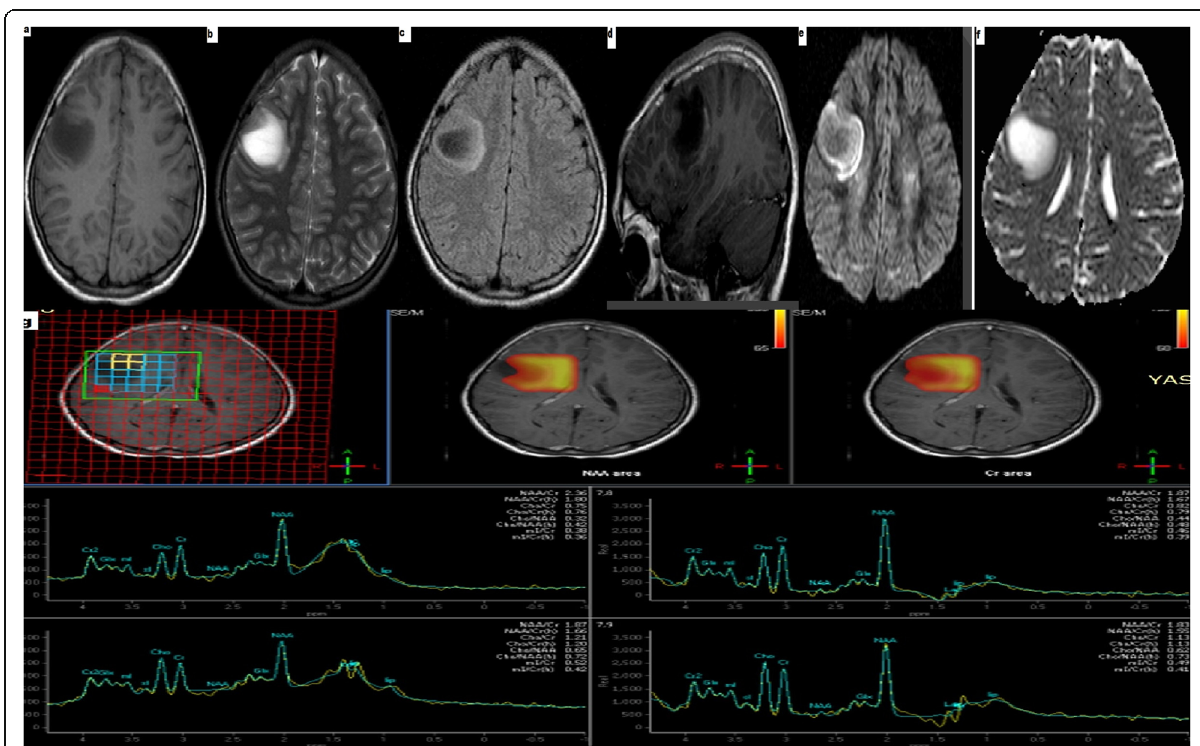
Fig. 5 “ An 11-year-old female patient ” MRI exam revealed a poorly defined lesions at the Lt. high parietal region that exhibit hypointense signal at T1 ( a ) and hyperintense signals with surrounding hypointense rim at T2 and FLAIR ( b , c ) and minimal perifocal edema. DWI and ADC map ( d , e ) showed mixed diffusion changes (restriction/T2 shin effect) with high ADC value. Post Gad ( f ) showed marginal ring contrast enhancement. MRS ( g , h ) revealed no significant changes either of NAA, Cr, or Cho peaks with presence of AA “ glycine (Gly) at 3.56 ppm; succinate (S) at 2.4 ppm; lipid/lactate (Lip/L) at 1.3 ppm at short MRS. Also, there is a well-defined abnormal signal intensity area seen at the Rt. frontal region (not included in selected images). MRI diagnosis: inflammatory process with Rt. parietal pyogenic brain abscess that proved on surgical aspiration of pus